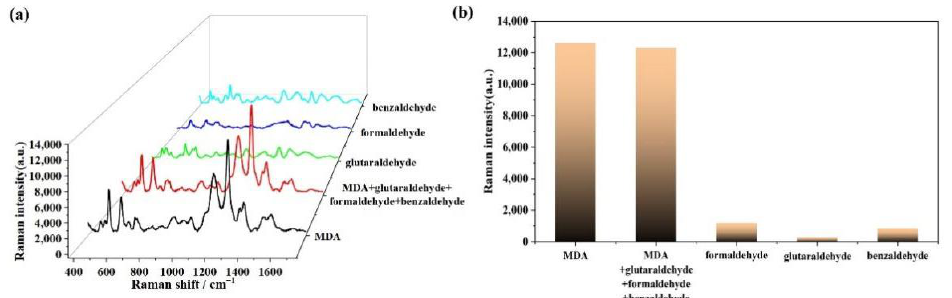
Figure 6. ( a ) SERS spectra of adducts of TBA reacted with different aldehydes, black line: MDA, red line: the mixture of MDA, glutaraldehyde, formaldehyde and benzaldehyde; green line: glutaralde- hyde; blue line: formaldehyde; cyan line: benzaldehyde ( b ) SERS intensities at 1272 cm −1 recorded from adducts of MDA, glutaraldehyde, formaldehyde, benzaldehyde and the product of mixture of MDA, glutaraldehyde, formaldehyde and benzaldehyde reacted with TBA.